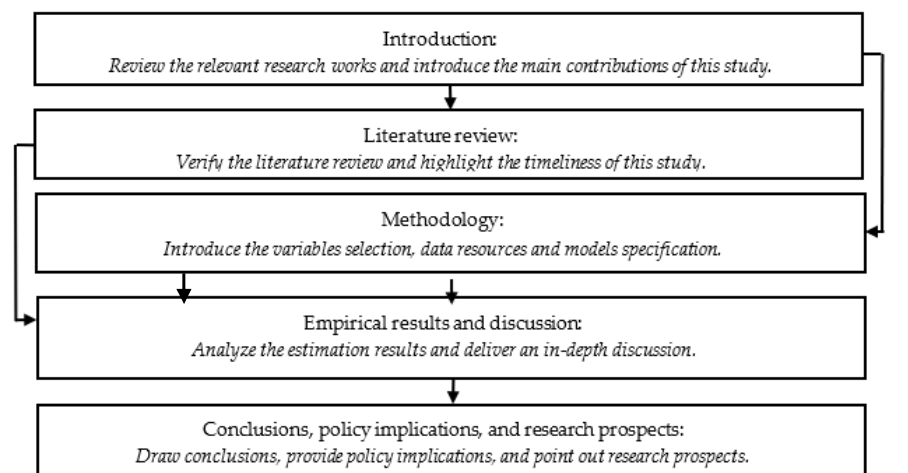
Figure 1. Research